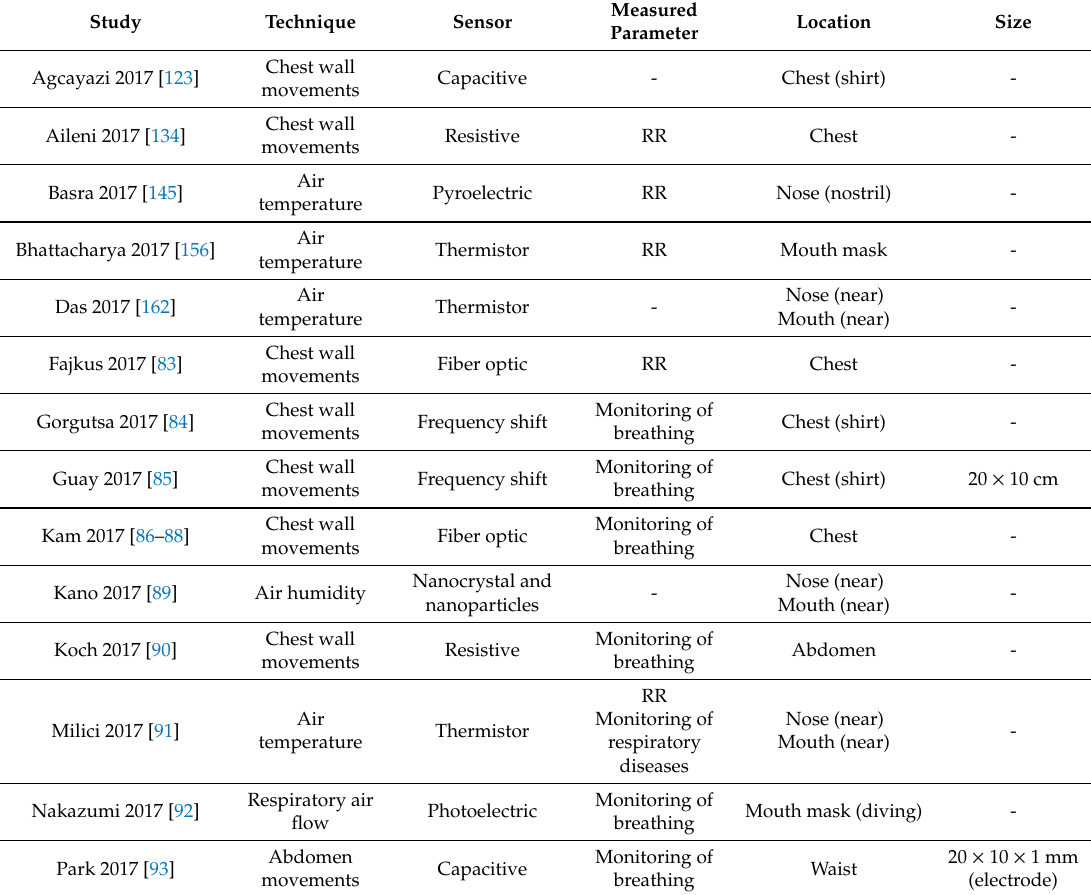
Table A1. Analysis of techniques, sensors, breathing parameters, and sensor locations and sizes for studies of the wearable category published before